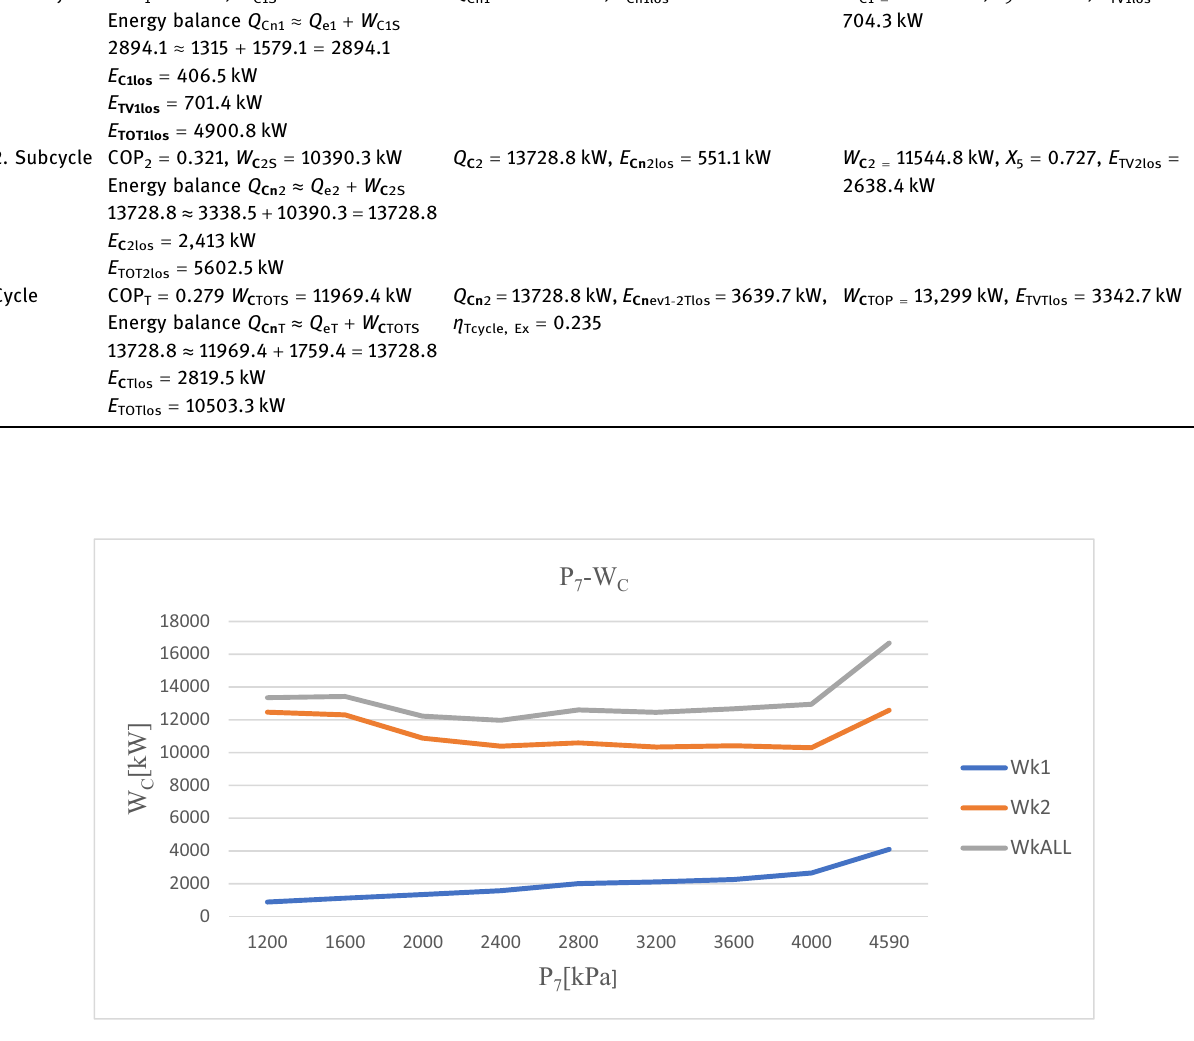
1. Subcycle COP 1 = 0.833, W C1S = 1579.1 kW